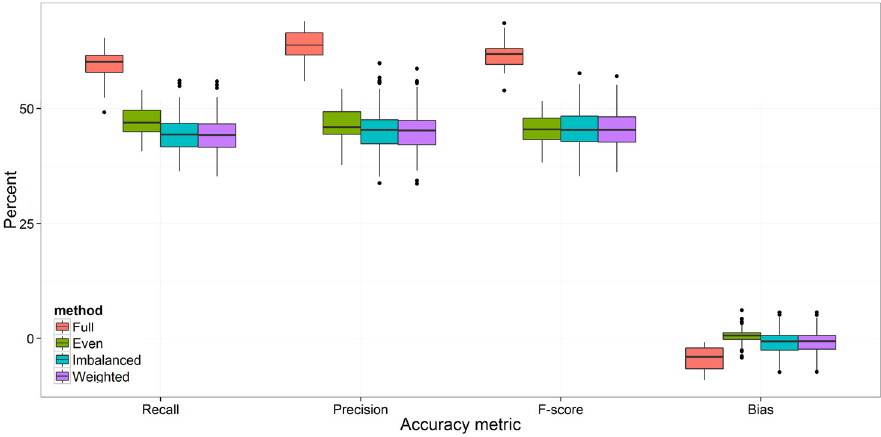
Figure 6. Model-level accuracy comparison of 4 SVM models that differ in input data. Model accuracy was measured with a 3-fold cross validation method (30 model iterations). The Even, Imbalanced, and Weighted models were run on a 400 crown subset of the full 890 crowns. Ten random subsets were done for a total of 300 model iterations. Paired t-tests between Imbalanced and Weighted model variations showed significant differences between variations for the F-score and bias metrics.